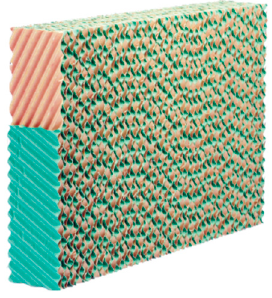
Figure 4. Evaporative cooling pad CELdek 7060-15. Table 2. Characteristics of the installed evaporative cooling pad, the selected cooling pad is highlighted with the grey background color.